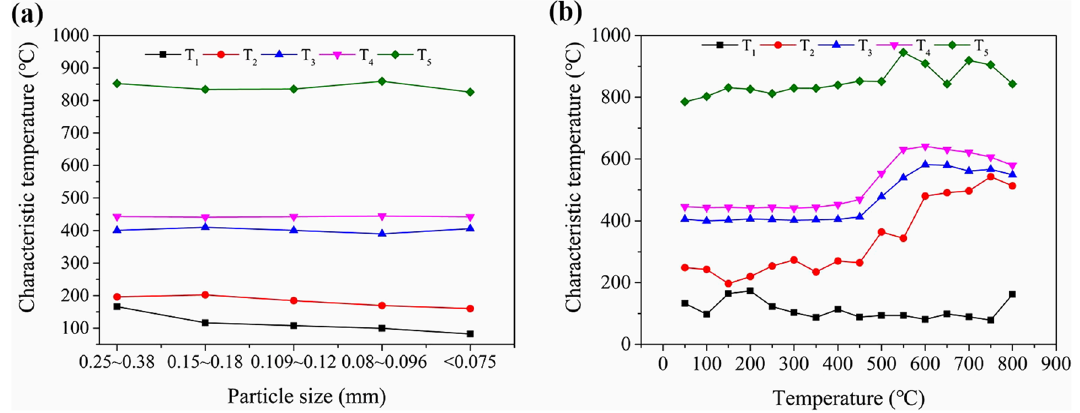
Figure 7. Results from TG experiments ( a the characteristic temperatures with different particle sizes; b the characteristic temperatures of heated